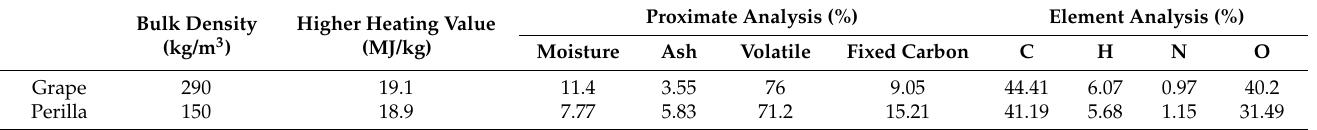
Figure 4. Thermochemical conversion of biomass [2]. Table 1. Raw sample properties of Grape and Perilla.